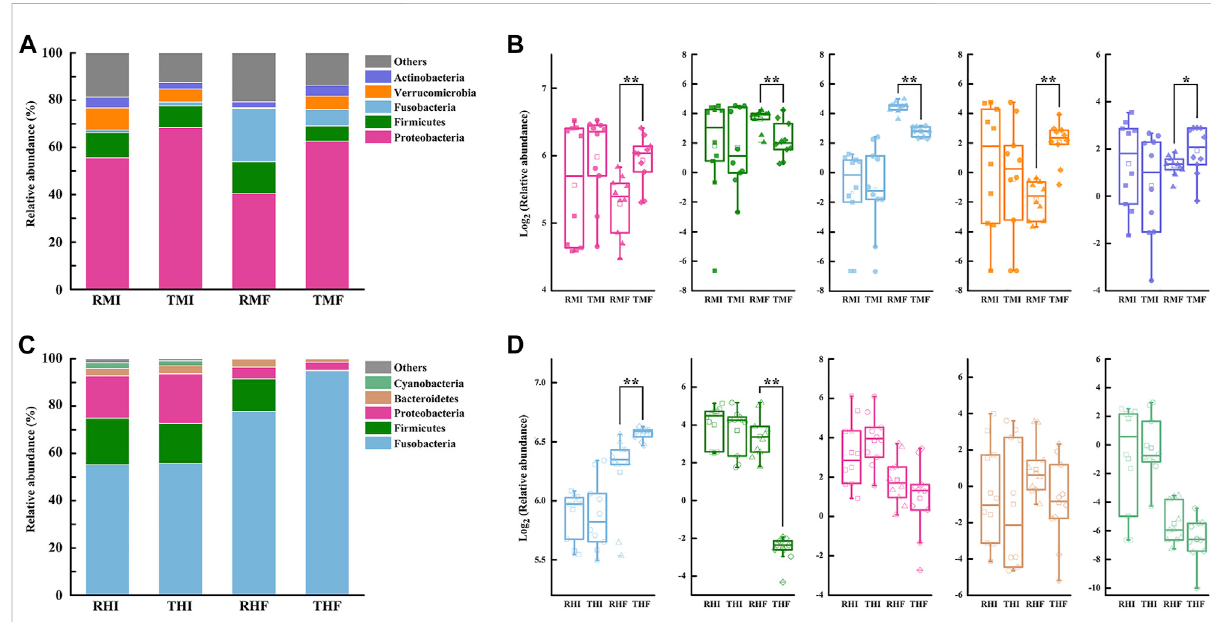
FIGURE 4 Histograms of relative abundance of intestinal bacteria in genetically improved farmed tilapia (GIFT), for predominant taxa identi fi ed at the phylum level, in (A) midgut and (C) hindgut (each bar represents relative abundance in each sample; only the fi ve-most-abundant taxa are shown). Boxplots representing abundance of bacterial phyla in GIFT (B) midgut and (D) hindgut (lines in boxes represent medians of relative abundance). Signi fi cant difference in abundance between dietary groups are marked as * p < 0.05 or ** p < 0.01 (Mann – Whitney U